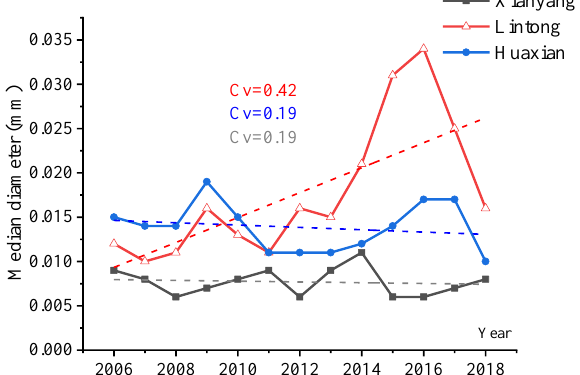
Figure 10. Variation of the median diameter of suspended sediment in the lower Weihe River in 2006 – 2018.